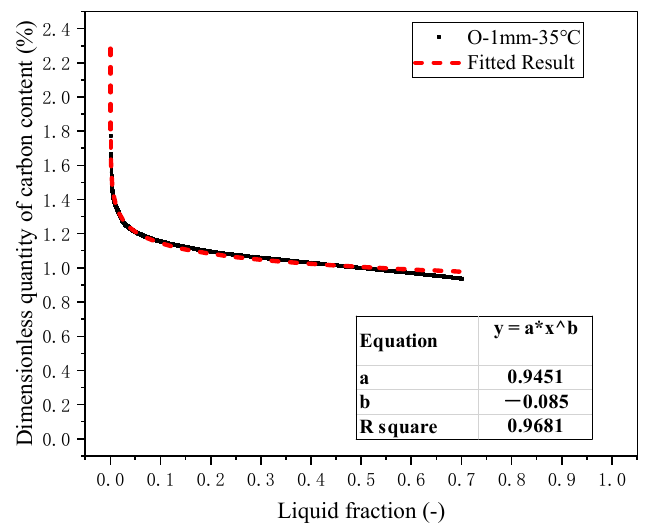
Figure 11. Example of the distribution of dimensional quantity of carbon content C d with 0 to 0.7 liquid fraction and its fitted equation. (The equation determination coefficient is 0.9681, which indicates that the fitted power-law equation can express the distribution very well). As C d can be considered as solid content C ∗ on the basis of Equation (1), Equation (3) S can be obtained on the basis of Equation (2) and be used to fit the content distribution like that in Figure 10 using the Levenberg–Marquardt algorithm [30]. These fitting calculations were carried out using Microsoft Excel software.